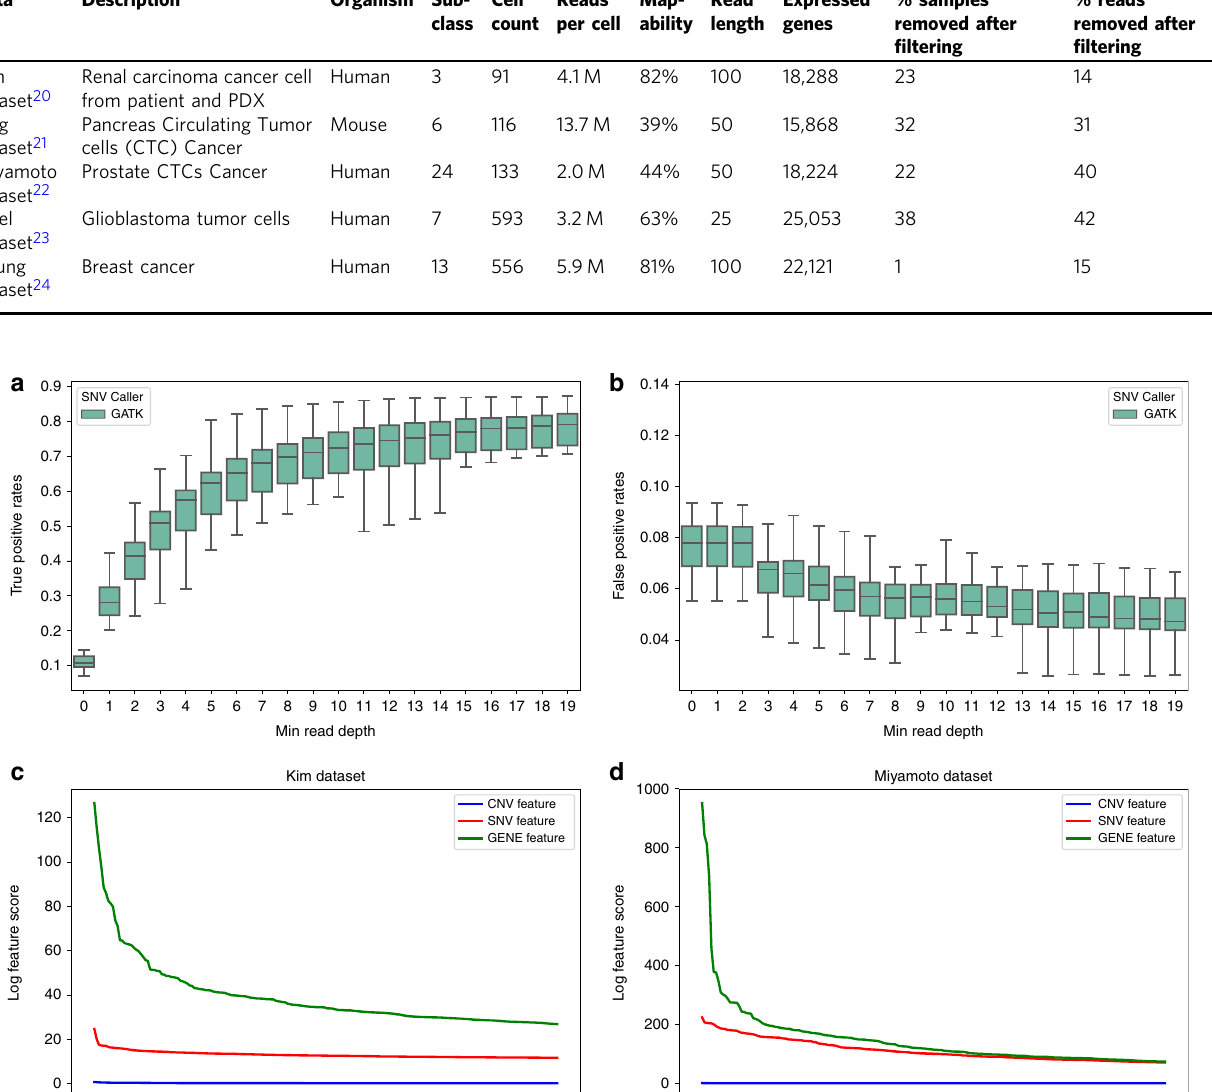
Table 1 Summary of scRNA-seq datasets used in this study Data Description